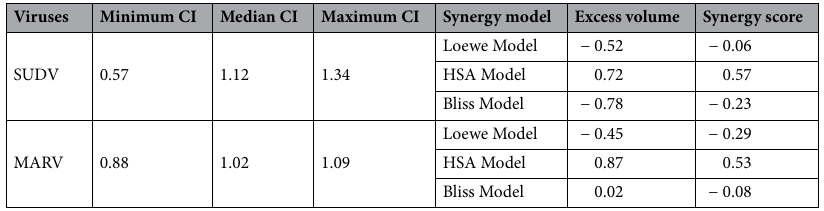
Table 2. Combination of RDV and favipiravir has additive effect on the antiviral activity against SUDV and MARV infections in cells, as shown by the combination index (CI), excess volume, and synergy score values. CI combination index, HSA highest single